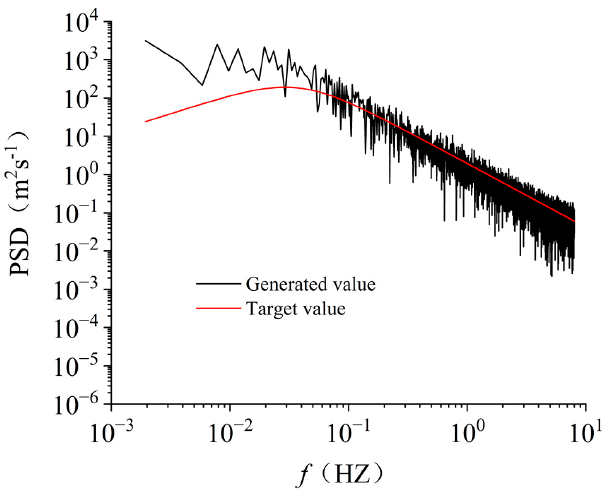
Figure 6. ABL wind speed time-history.